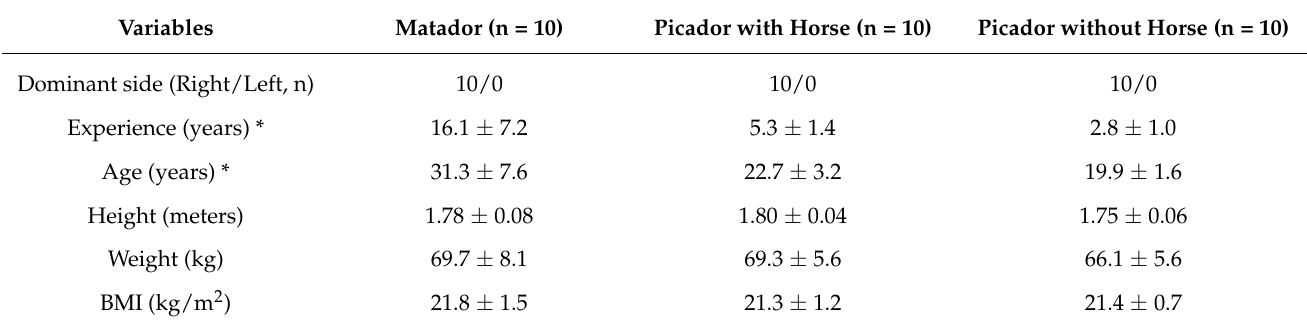
Table 1. Socio-demographic Characteristics of the